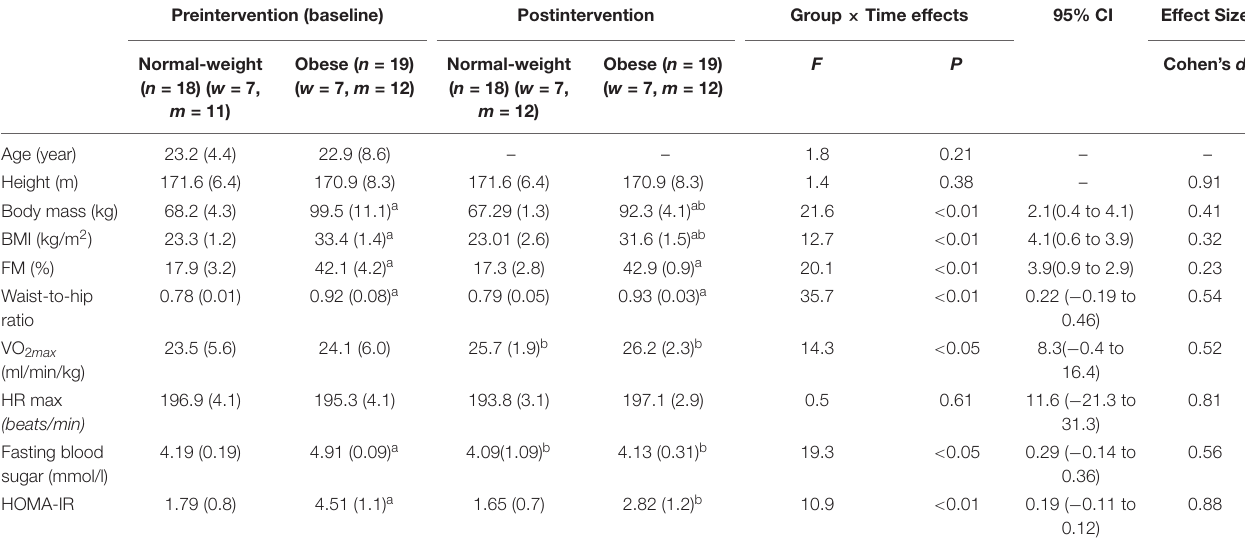
TABLE 1 | Age, anthropometric and fitness data at pre and after 6-week supramaximal exercise training. Preintervention (baseline) Postintervention Group × Time effects 95% CI Effect